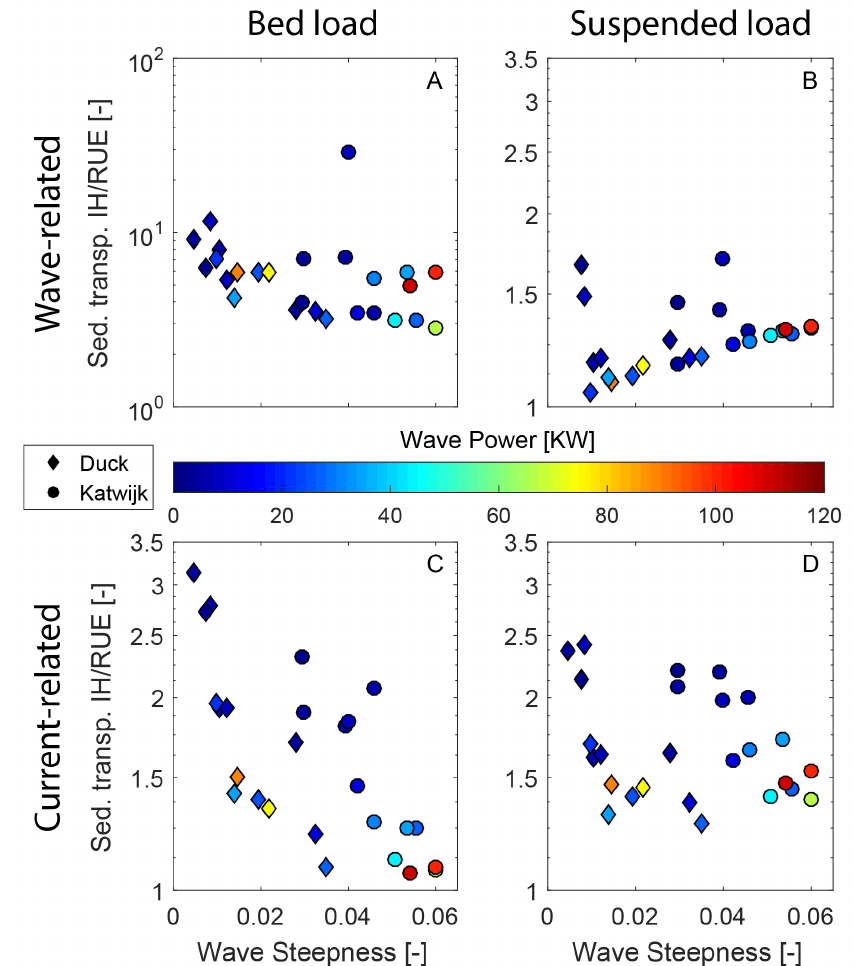
Figure 12. Tidally integrated sediment transport factors of IH/RUE parameterizations against wave steepness at Katwijk and Duck, with colors representing the wave power for each wave case from the climate (Table 2). ( A ) wave-related bed load; ( B ) wave-related suspended load; ( C ) current-related bed load; ( D ) current-related suspended